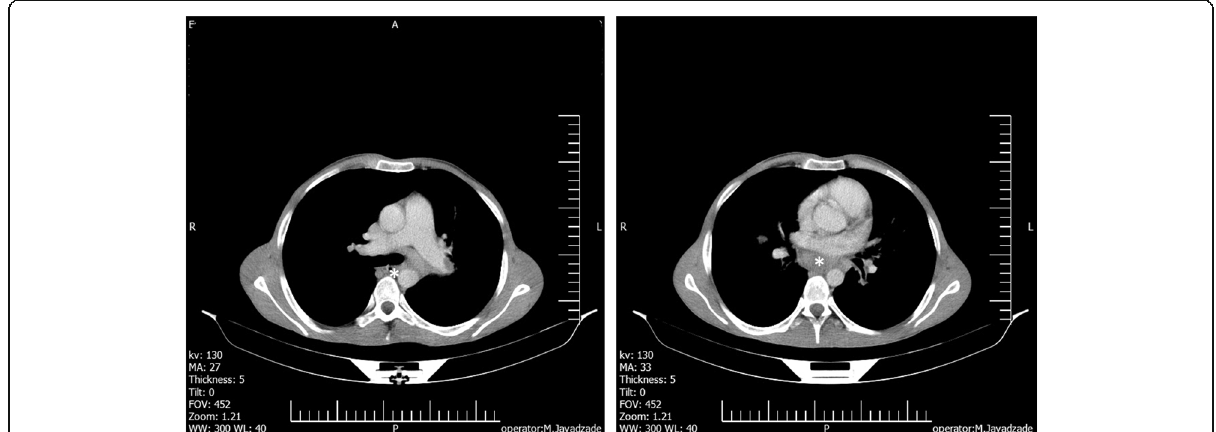
Fig. 3 Subcarinal lymphadenopathy detected by CT with venous contrast. The lymphadenopathy is shown by the